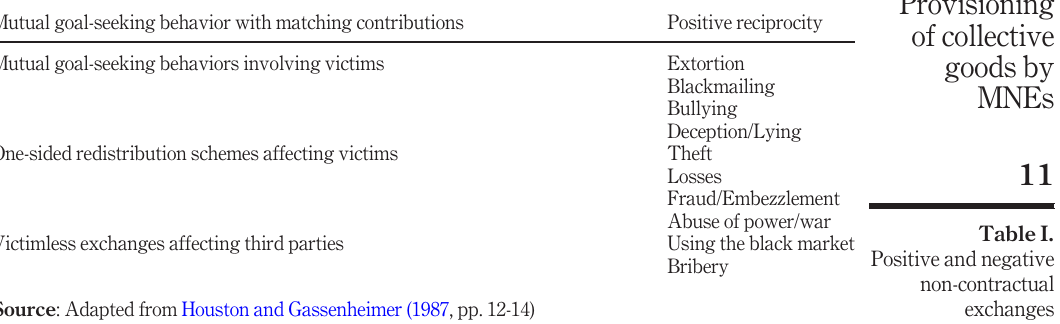
Table I. Positive and